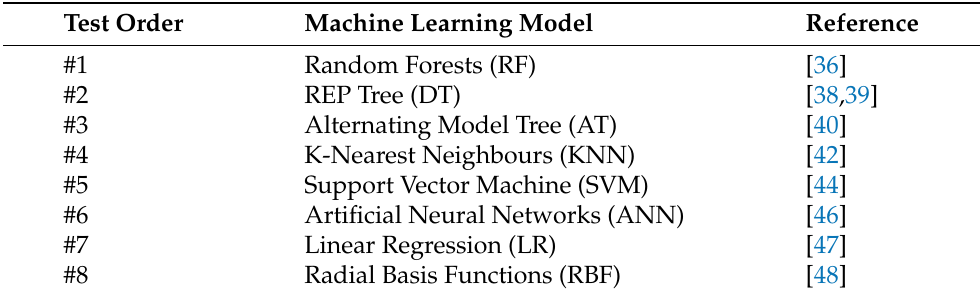
Table 1. UAV-based datasets that are publically available from previous